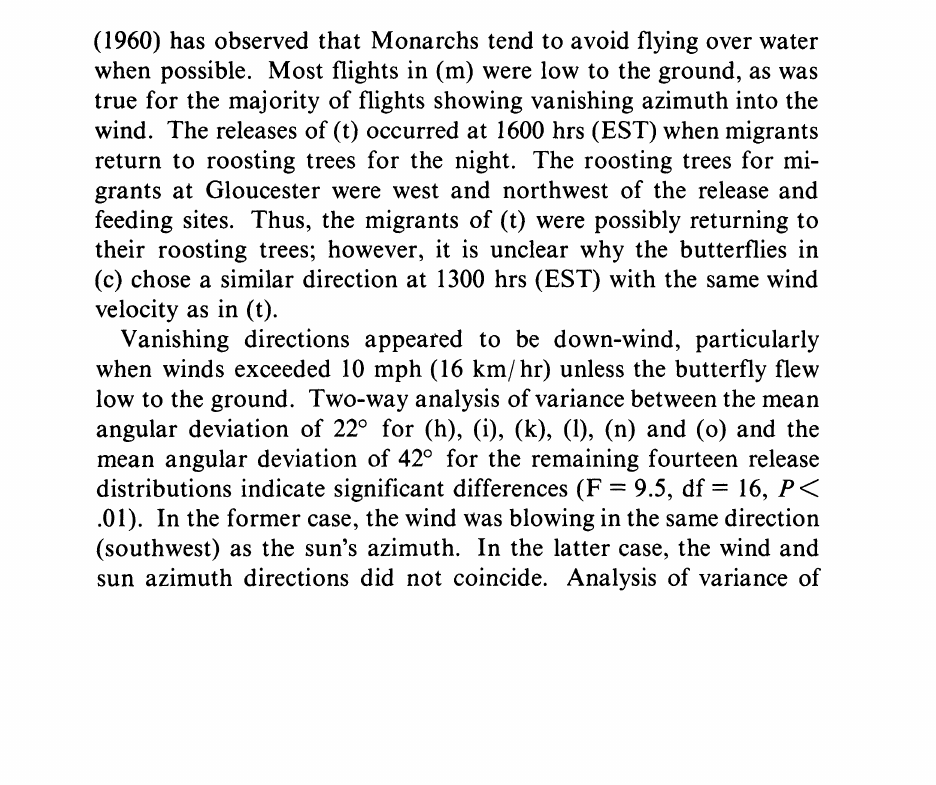
Fig. 6. Release orientation for summer monarchs on overcast days. Symbols are as in Fig. 5. Most vanishing directions were